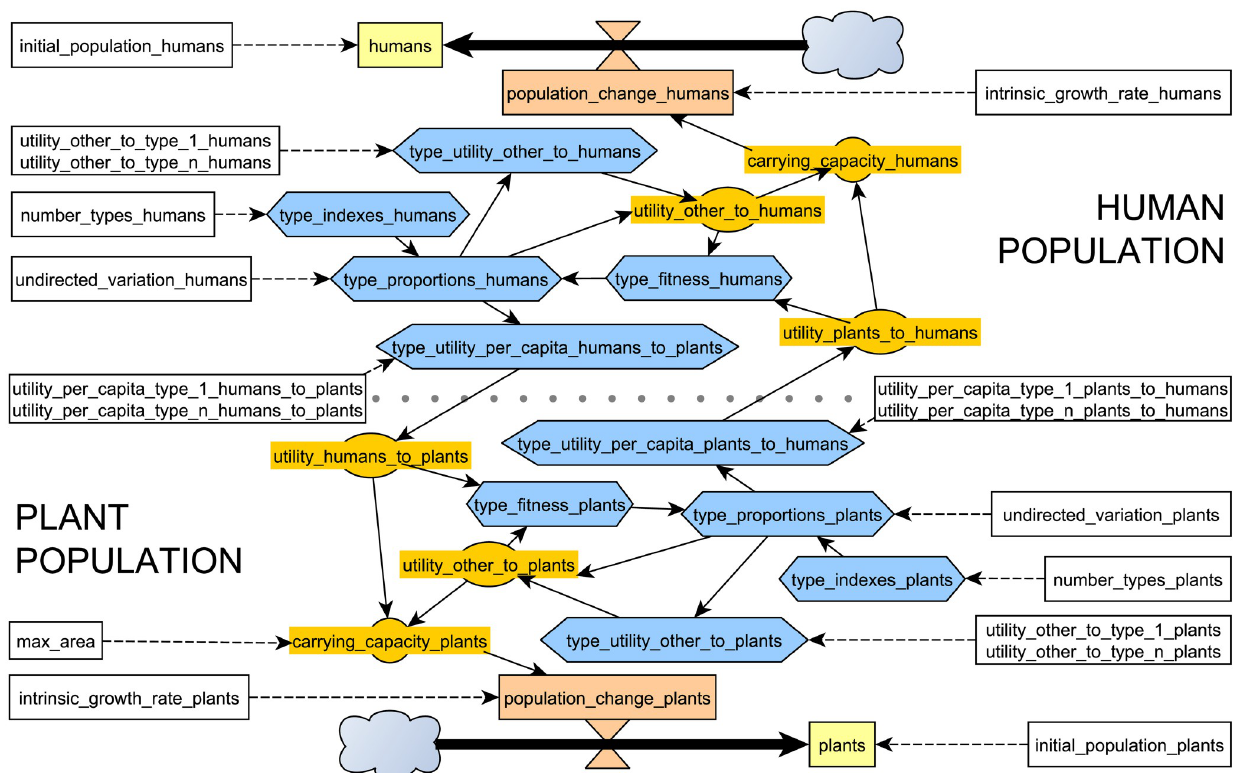
Fig 1. Simplified forrester diagram representing the relationships between parameters and main variables of the Human-Plant Coevolution (using R notation; see Tables 1 and 2). Populations are shown in yellow, their change in red, type-wise vector or array variables in blue, aggregate population variables in orange, and parameters in